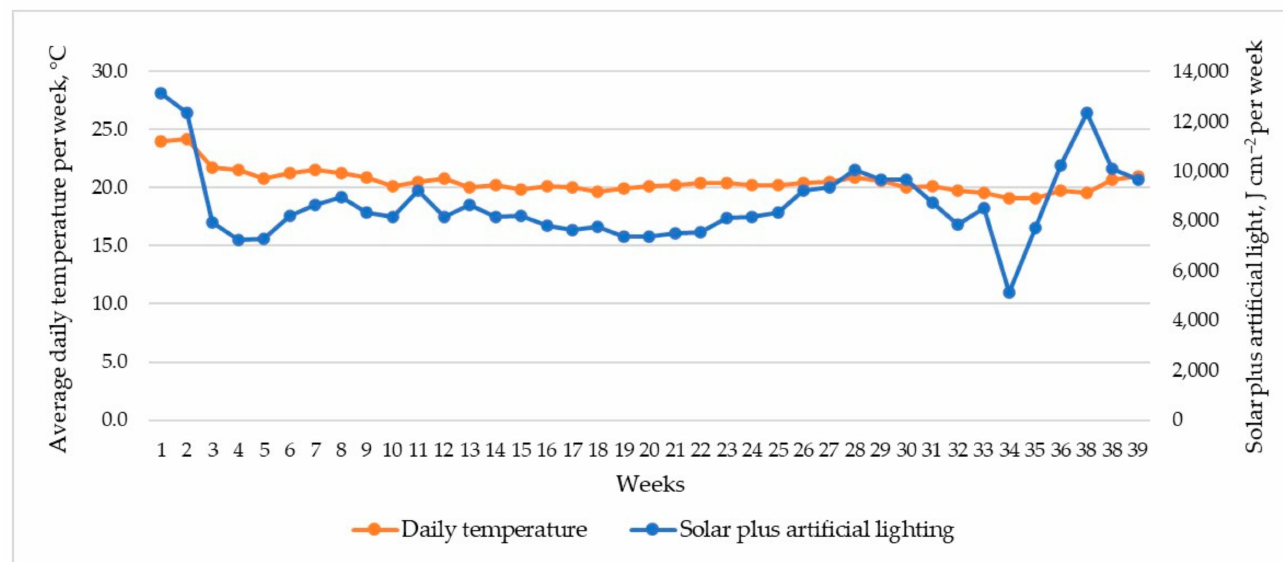
Figure 1. Average daily temperatures and solar plus artificial lighting per week during ‘Beorange’ tomato production cycle from August 2020 to May